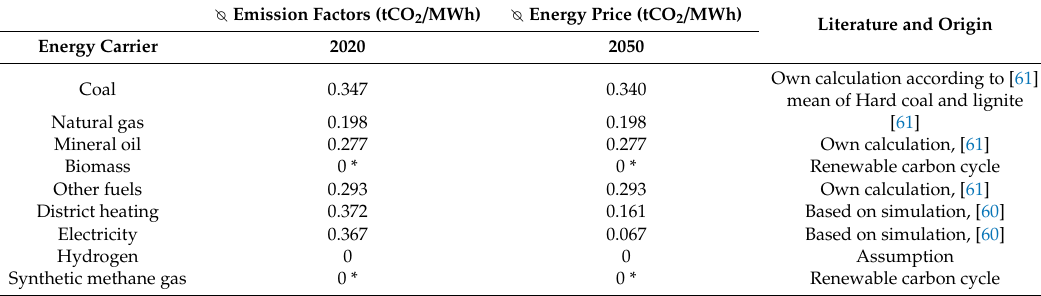
Table A3. Emission factors used in the technology mix scenario.